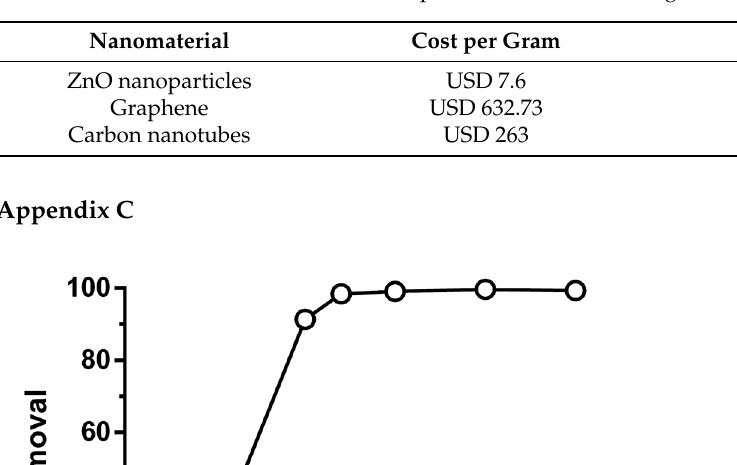
Table A2. Costs of nanomaterials for adsorption treatment technologies.